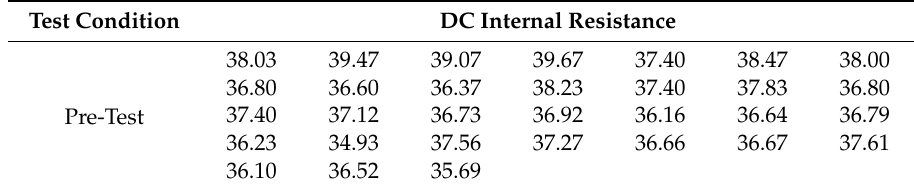
Table 2. DC resistance distribution before vibration test (m Ω ).